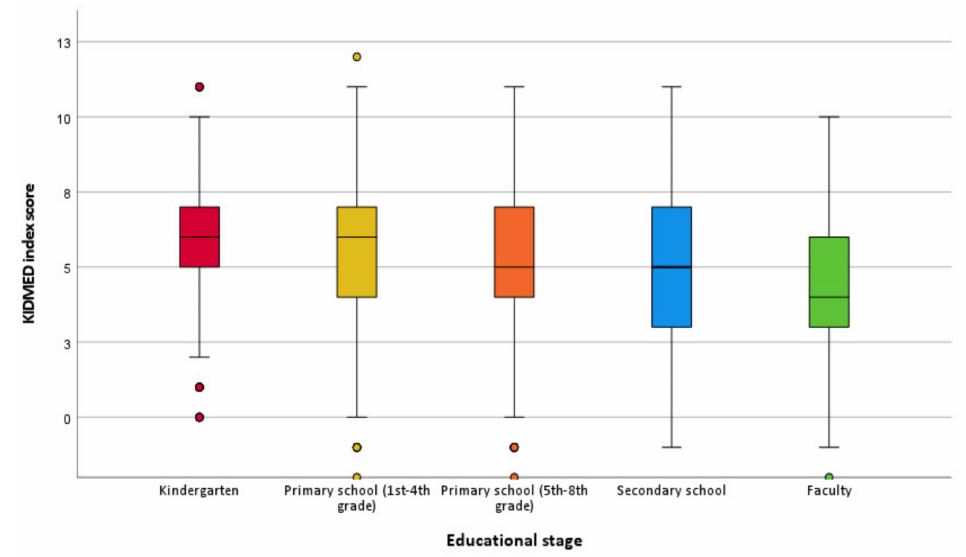
Figure 1. Box–plots for the KIDMED index score for different educational stages. Basic descriptive statistics of the 16 KIDMED items according to educational